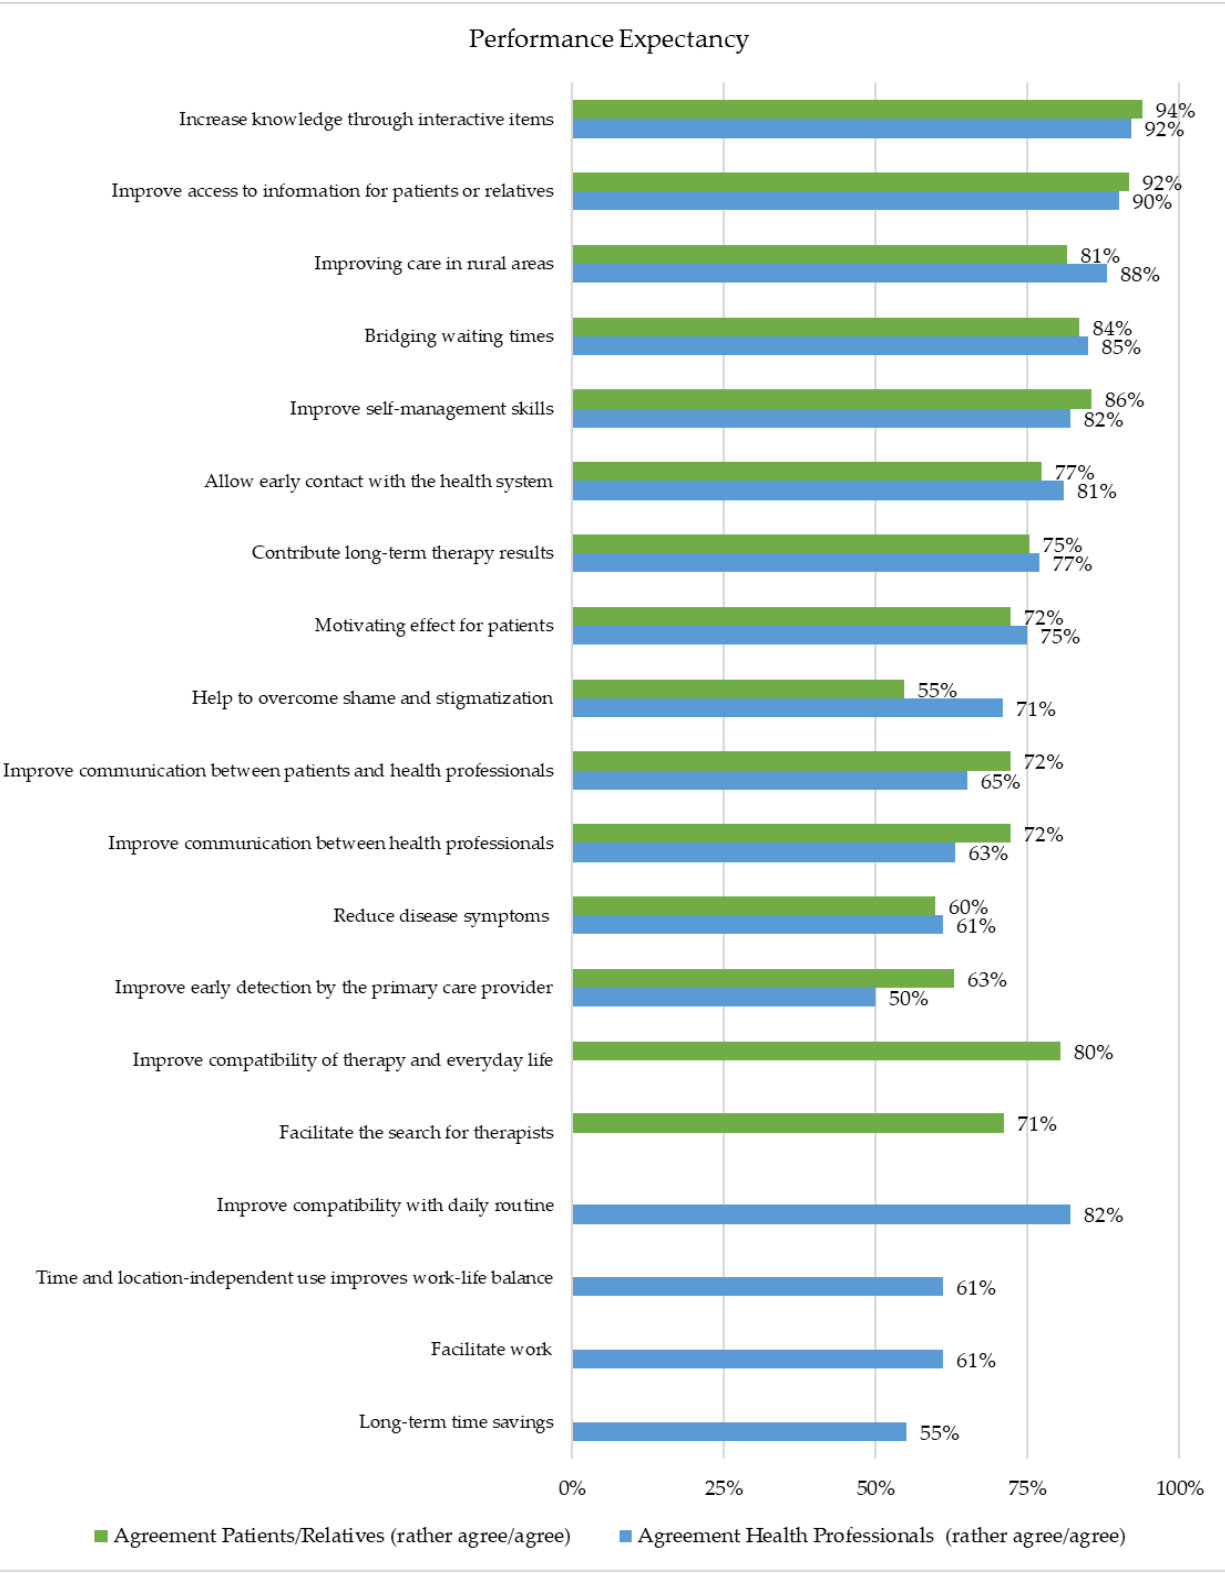
Figure 2. Representation of the Performance Expectancy (Patients/Relatives ( n = 97) and Health Pro- fessionals ( n = 229)).